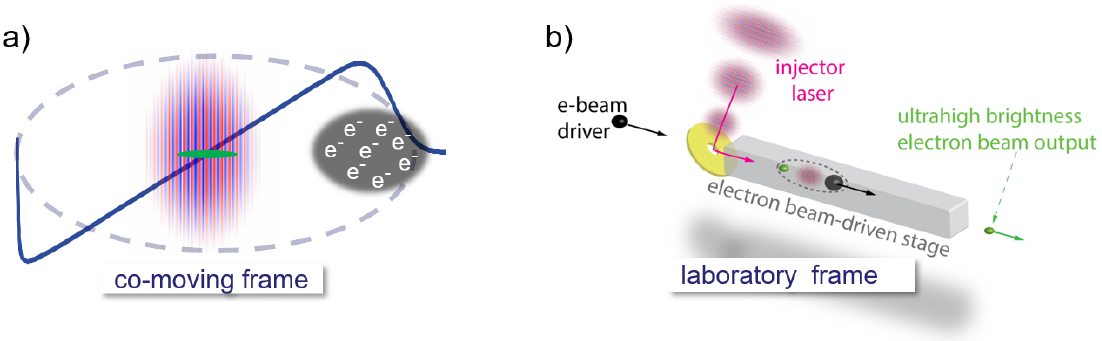
Figure 10. ( a ) Collinear Trojan Horse schematic in the co-moving frame; and ( b ) laboratory frame. The laser focusing pulse releases ultracold electrons (green) from the high ionization threshold medium, which then briefly fall back and are trapped in the back part of the accelerating